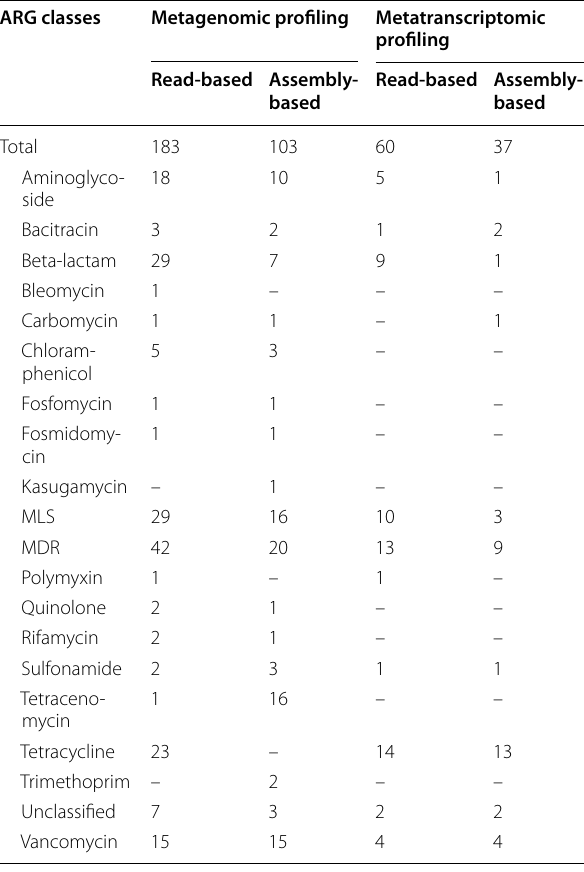
MLS macrolides-lincosamides-streptogramins; MDR multi-drug